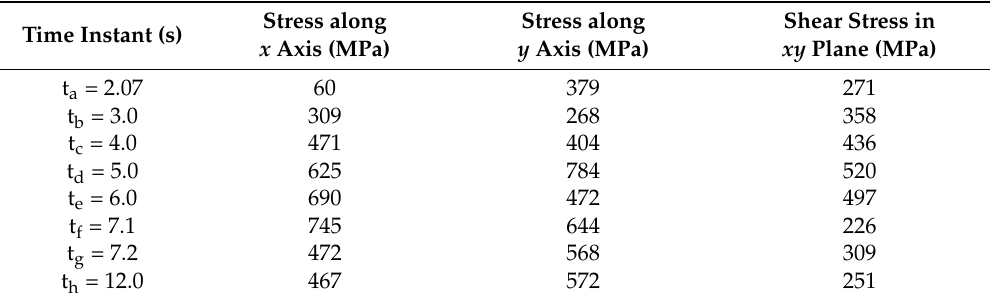
Table 4. Juxtaposition of maximum constituent stress values in a sheet being cut for selected time instants during numerical cutting process.